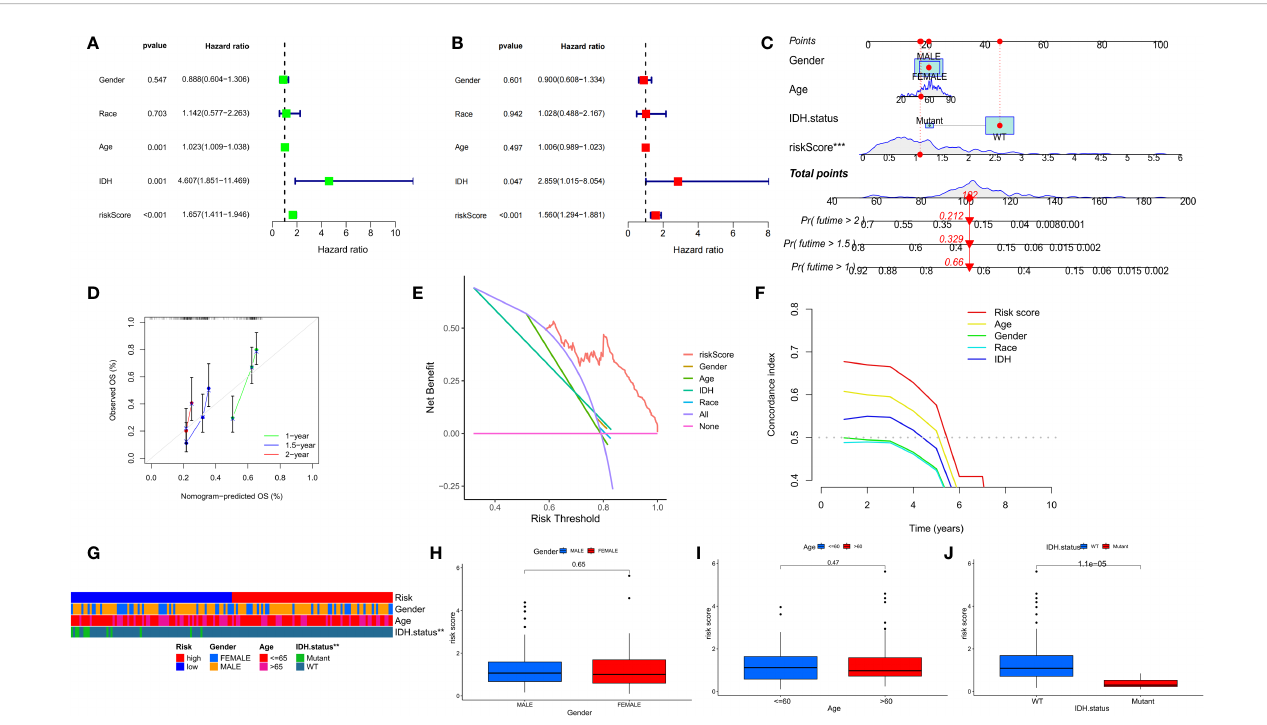
FIGURE 8 Prognostic value of risk scores and clinical characteristics in GBM patients. (A) Univariate and (B) multivariate COX analysis for evaluating the prognostic signature and clinical features (including age, race, gender, and IDH state). (C) Nomogram of risk groupings and clinical characteristics for predicting survival at 1, 1.5, and 2 years. (D) Calibration curves for testing the agreement between actual and predicted outcomes at 1, 1.5, and 2 years. (E) DCA curves of risk scores and clinical characteristics for the TCGA cohort at 3 years. (F) The concordance index (C-index) for the TCGA cohort. (G) Bar charts of clinical characteristics associated with risk grouping determined by chi-square test. (H – J) Variations in risk scores among the TCGA cohort ’ s various clinical characteristic groupings *p < 0.05, **p < 0.01, ***p <